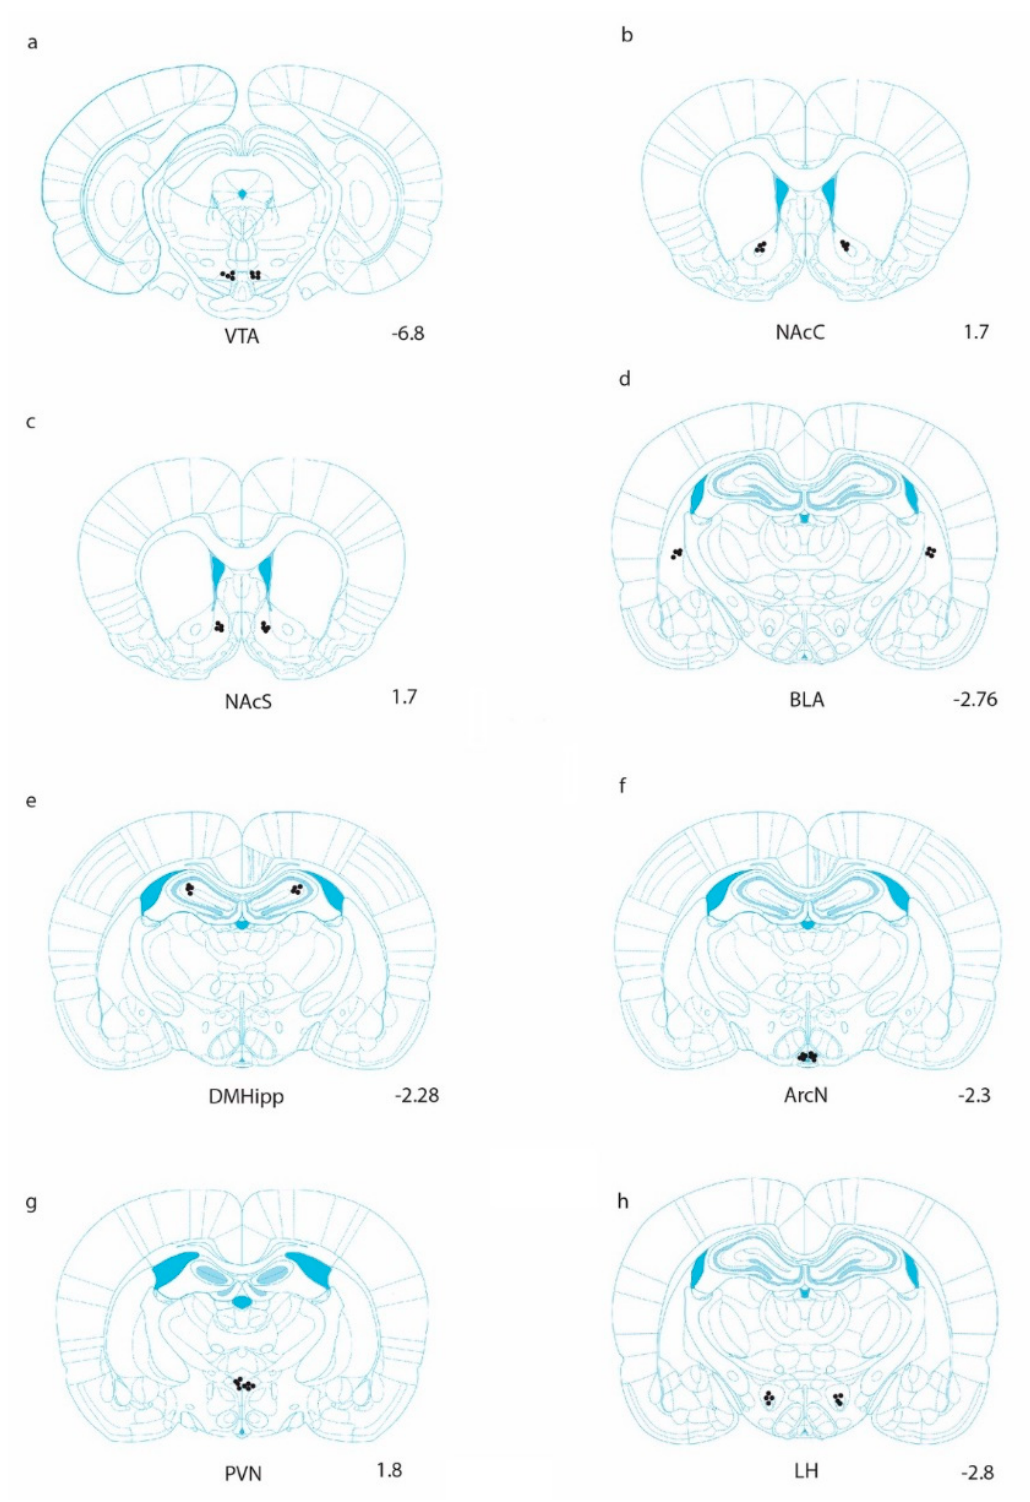
Figure 1. Anatomical representation of injection sites in which Ex-4 was unilaterally delivered. Injections were counterbalanced in the left and right hemispheres [44]. Coronal sections are shown for ( a ) the ventral tegmental area (VTA), ( b ) the nucleus accumbens core (NAcC), ( c ) the nucleus accumbens shell (NAcS), ( d ) the basolateral amygdala (BLA), ( e ) the dorsomedial hippocampus (DMHipp), ( f ) the arcuate nucleus (ArcN), ( g ) the paraventricular nucleus (PVN), and ( h ) the lateral hypothalamus (LH).